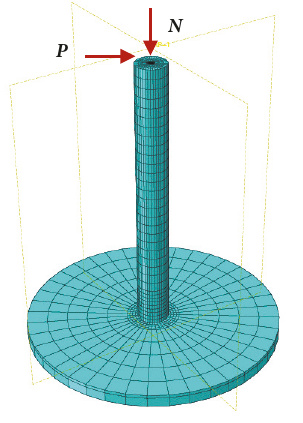
Figure 3: Finite-element model of CFJ.